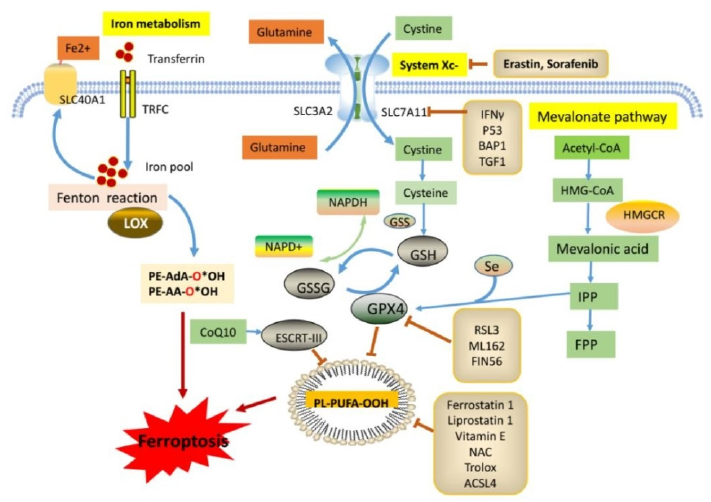
Figure 2. Molecular regulation mechanism of ferroptosis. Three main regulatory pathways govern ferroptosis development: the iron metabolic pathway, system Xc–/GSH/GPX4 pathway, and lipid metabolic pathway. Iron metabolic pathway includes Fe 2+ , transferrin, LOX, and then triggers Fenton reaction to induce ferroptosis. Activation of Xc–/GSH/GPX4 system protecting cells from ferroptosis, which is via reducing the generation of ROS and the following PL ‐ PUFA ‐ OOH. Lipid mulation of intracellular free fatty acids to trigger ferroptosis.GPX4: Glutathione peroxidase 4; GSH: Glutathione; LOX: Lipoxygenase; PUFAs: Polyunsaturated fatty acids; ROS: Reactive oxygen species; PL ‐ OOH: phospholipid hydroperoxides. Arrow indicates promoted ferroptosis. Bar rep ‐ resents inhibited